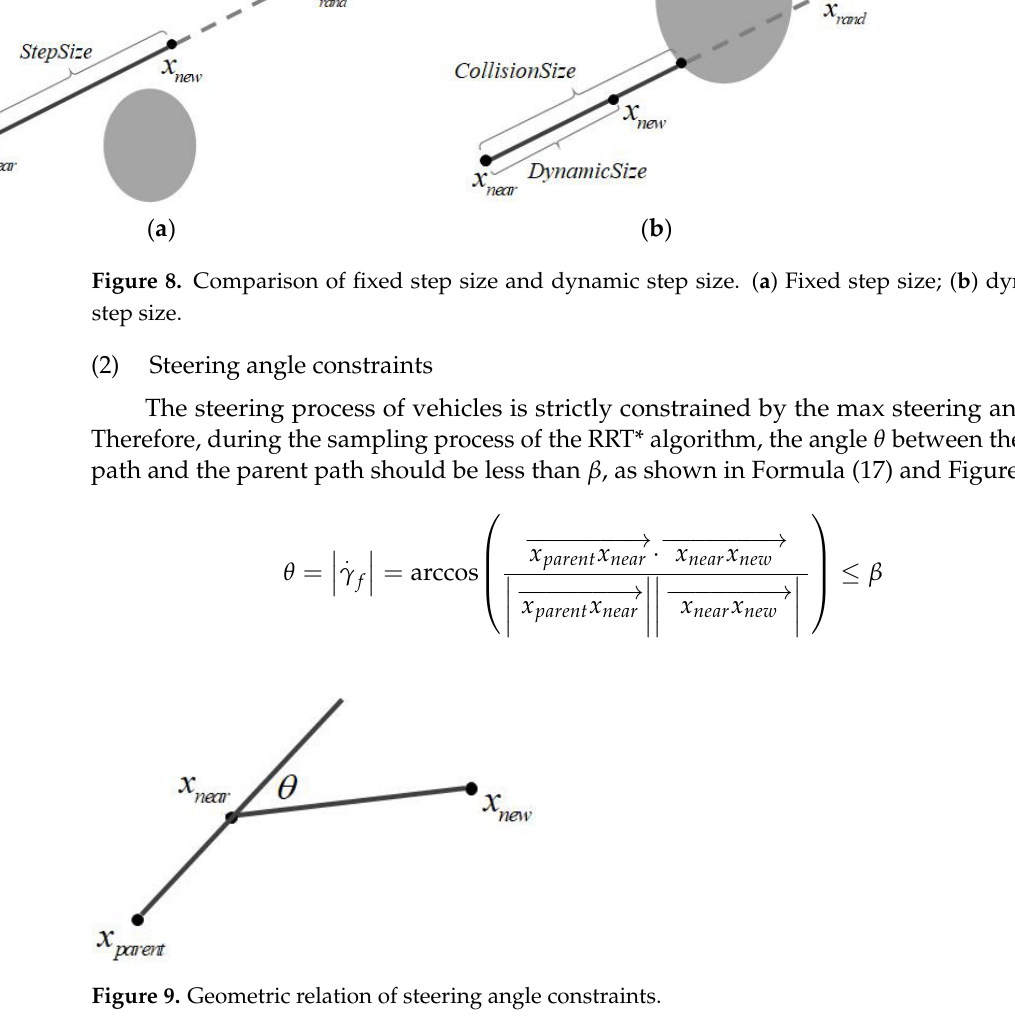
Figure 9. Geometric relation of steering angle constraints.